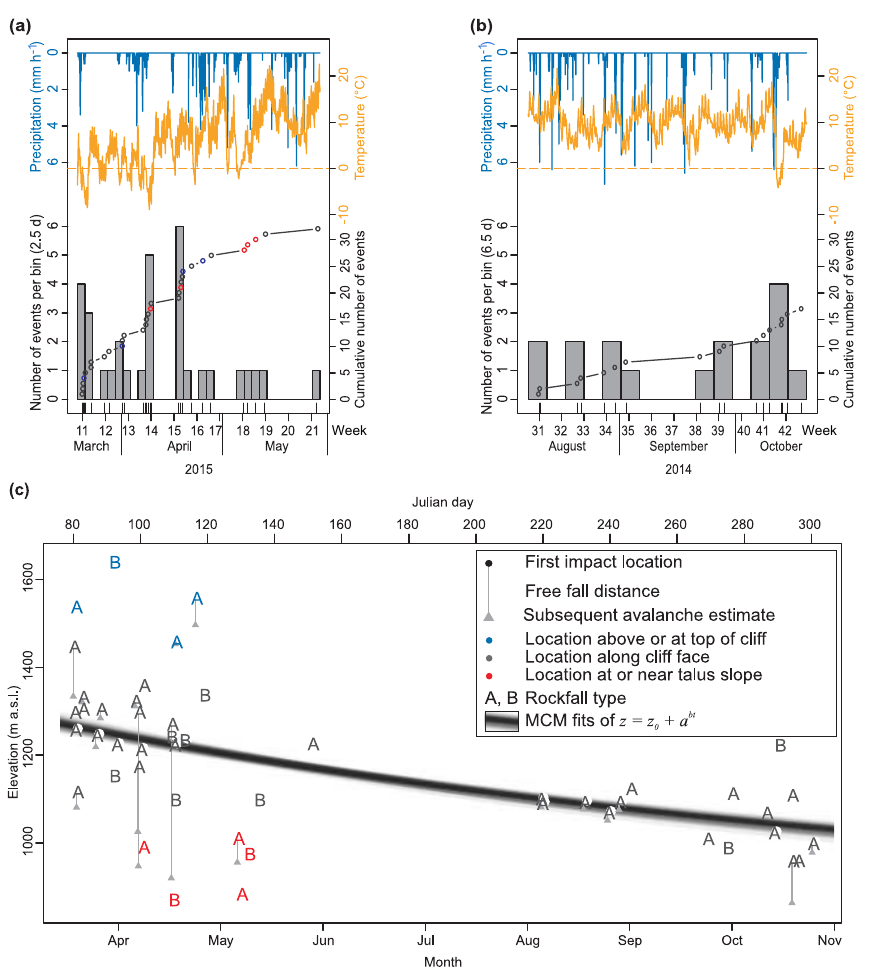
Figure 6. Temporal patterns of rockfall activity. (a) Times series of all detected rockfalls from spring 2015. (b) Time series of summer– autumn 2014. Histogram bars and rug show rockfall events, and the circle–line graph shows the cumulative number of events. For the colour of circles, see legend to panel (c) . The dashed orange line depicts zero degrees. (c) Height of the seismically estimated first rock mass impact as a function of month of the year (note that 2014 events are plotted to the right of the 2015 events). Grey vertical lines and triangles give projected downslope displacement (where possible) due to gravitational acceleration and time offset to subsequent avalanche emergences. Letter denotes phenomenological rockfall type. Semi-transparent graphs are Monte-Carlo-based exponential fits of the elevations of the events denoted in